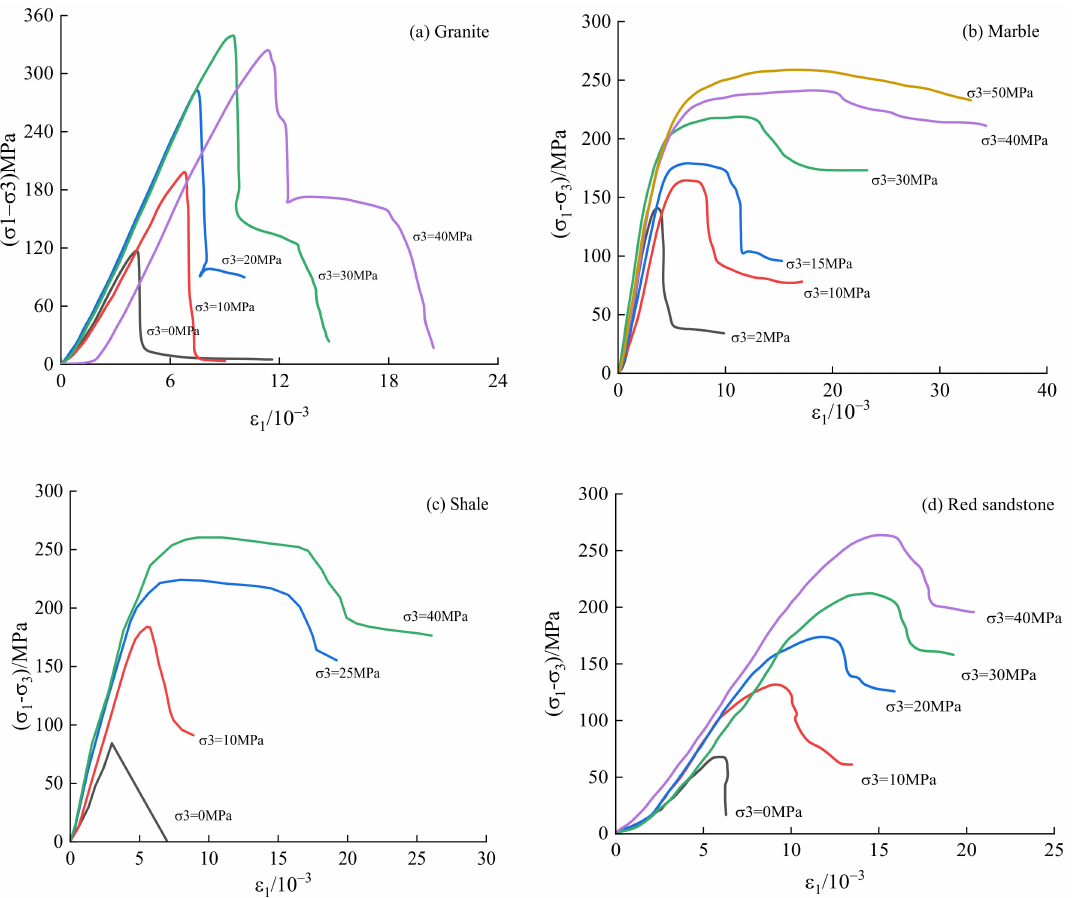
Figure 3. Stress–strain curves of various rocks under different confining